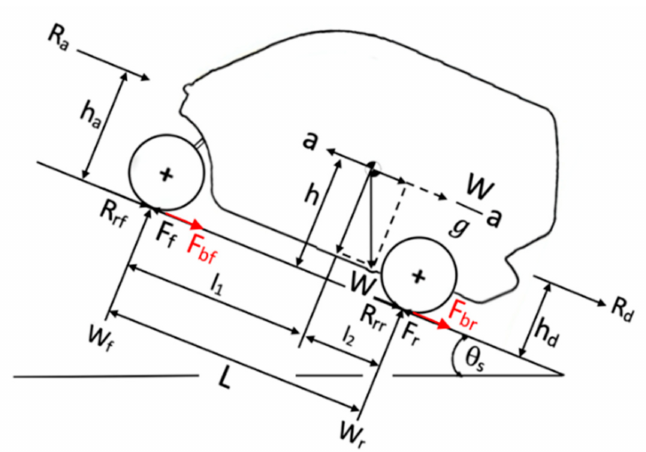
Figure 3. Free body diagram of external forces acting on an